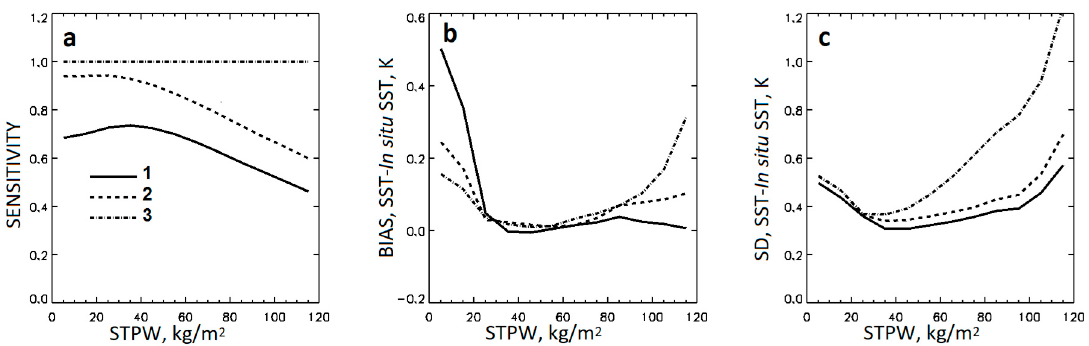
Figure 4. ( a ) Sensitivity, ( b ) bias and ( c ) standard deviation with respect to in situ SST of the (1) GR-IS SST, (2) GR-L4 SST, and (3) PWR-L4 SST. All shown as functions of slant-path total precipitable water vapor content,